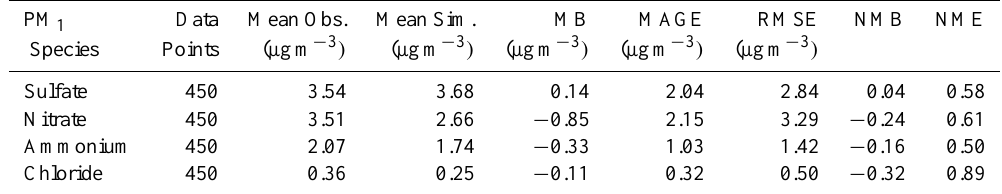
Table 3. Comparison of PMCAMx predictions with hourly observations taken at T0 during 10–31 March 2006.